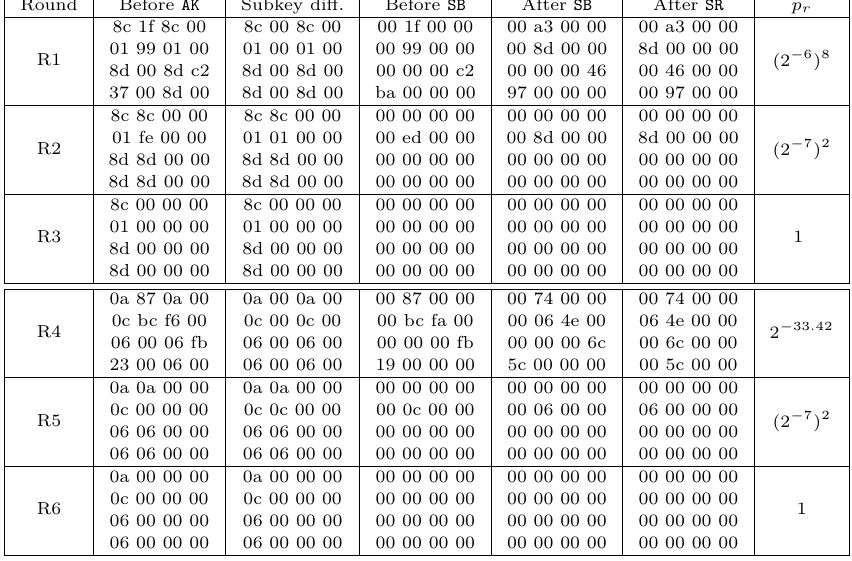
Table 6: 6-round related-subkey boomerang distinguisher of AES -128 with probability 2 − 109 . 42 Round Before AK Subkey diff. Before SB After SB After SR p